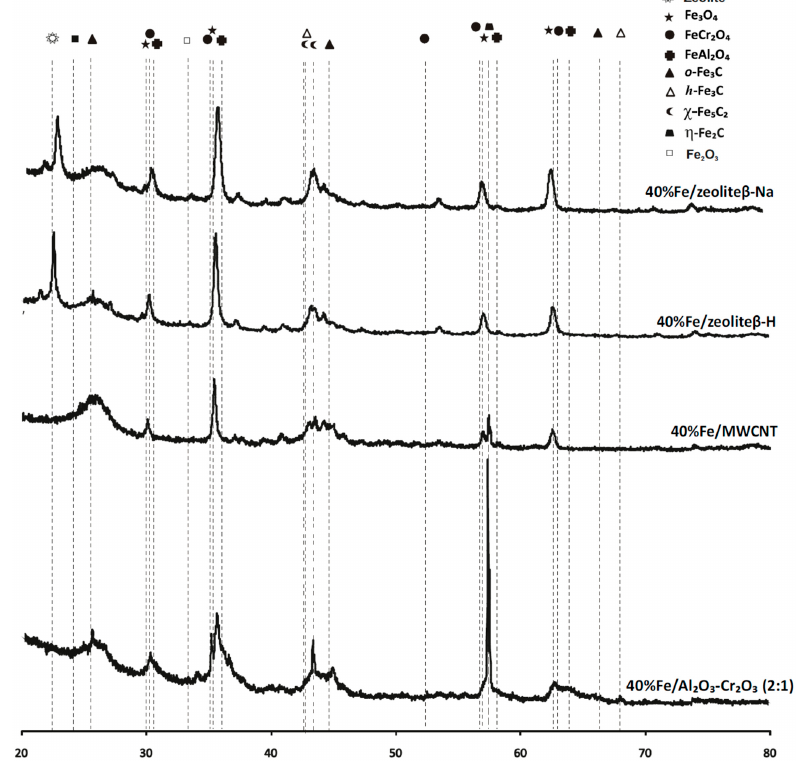
Figure 7. The X-ray diffraction patterns recorded for the spent iron catalysts supported on binary oxide, MWCNTs, zeolite β -H -Na and zeolite β -H.